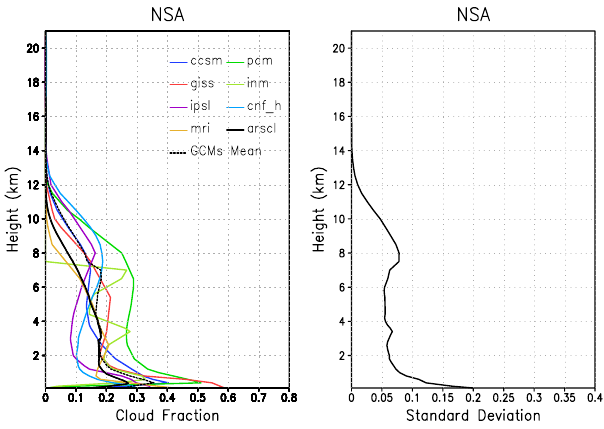
Fig. 13. Same as for Fig. 9, but for NSA.